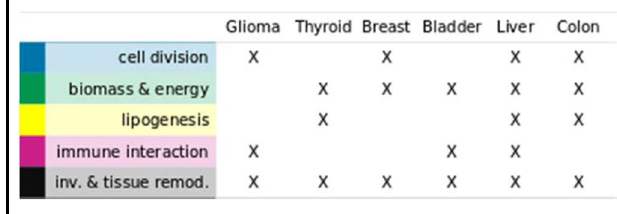
X indicates the signi fi cant overlap between cancer archetype and universal archetype in the set of genes whose expression is enriched in tumors closest to archetype (see “ Methods ”